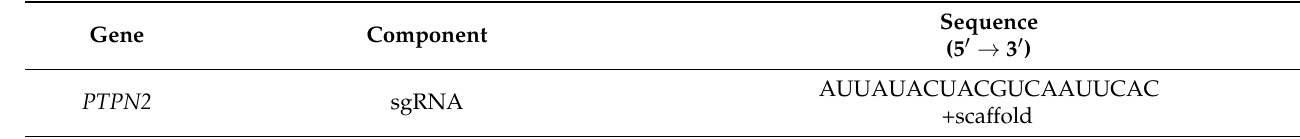
Table 2. Synthetic single-guide RNA and donor DNA